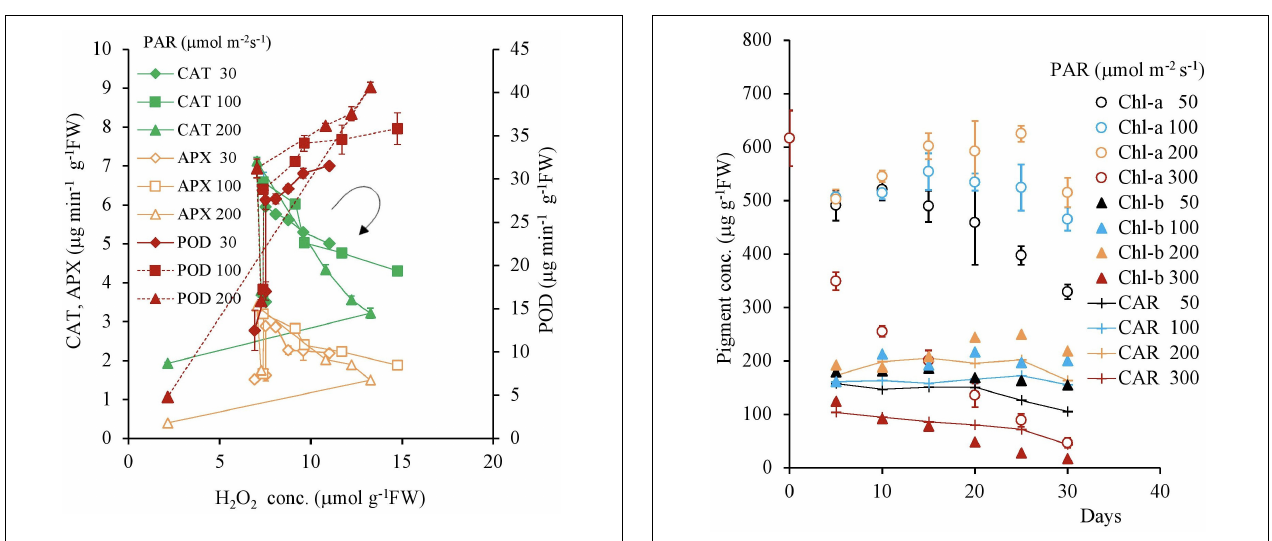
FIGURE 10 | The variational trend of the pigment concentration of plant tissues with respect to various light intensities. Vertical bars indicate the standard